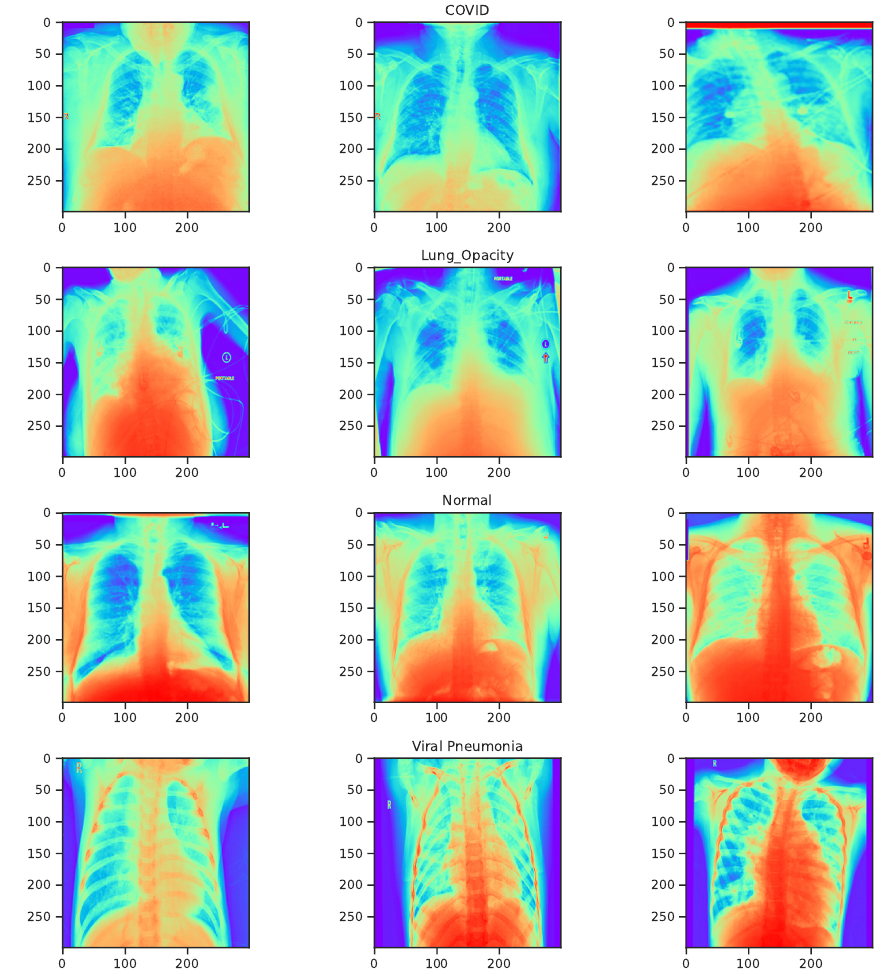
Figure 6. A comparison illustrating a plot of the 3 colors channels. Figure 7, gives a depiction of the dataset projected onto a two-dimensional plane, shows that most of the data points are clustered in the central region of the graph. That implies the inter-class pixel intensity variability is low. However, COVID-19 samples show some clusters with a high channel colour mean and pixel intensities laying between 150 through 200. This can be visualized in Figure 7 (bottom-panel), a 10% zoom in the centre of Figure 7 (top-panel). It can be observed that the samples with a lower mean and a low standard deviation are in the lower corner and the upper corner has the converse situation. Because of the dense clustering of data points in Figure 7, which gives a high- level overview of the dataset but not fine-grain information, a plot of class-level depictions of the dataset is shown in Figure 8. We observe that the classes (COVID-19, Lung Opacity, and Viral Pneumonia) have high intra-class variability with outliers that are distant from the centroid. Figure 8 shows that Normal (Healthy) and Lung Opacity have similar data point cluster formations. This similarity in distributional pattern between the two classes is characterised by the spread of the respective graphs where a majority of the samples are along regions of high standard deviation, and within 100 to 180 mean pixel intensities. Viral Pneumonia images, on the other hand, show a denser scatter plot which is due to the samples having higher in-class similarity. The graph of the COVID-19 does not indicate any semblance to the other three classes. It has a higher variance and more outliers compared to the other classes. The data points are scattered across all regions of the